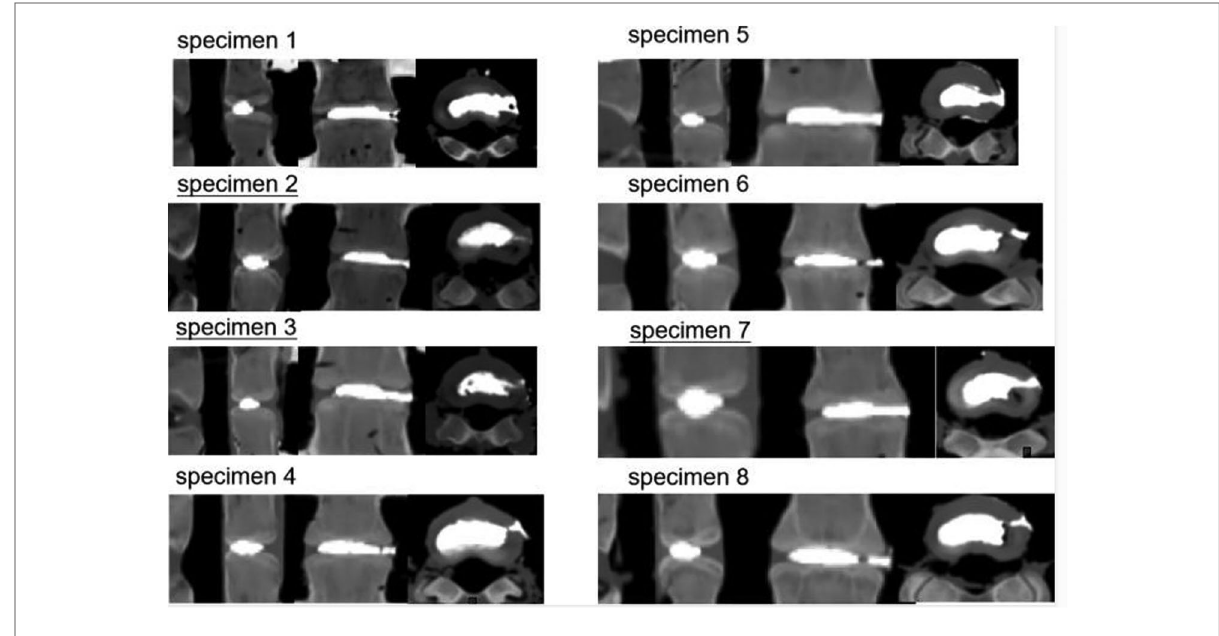
FIGURE 7 CT scan of specimens treated with discoplasty.